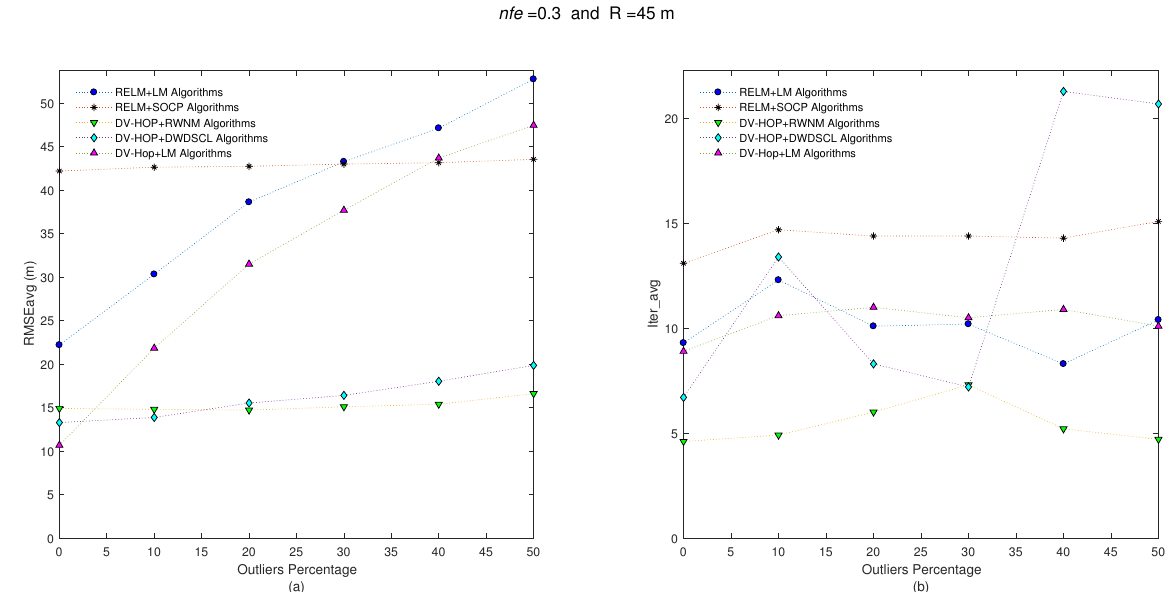
Figure 6. ( a ) RMSEavg and ( b ) Iter _ avg after running five iterative algorithms over 10 multi-hop isotropic networks with R = 45 m and nfe = 0.3. Outliers levels are increased by steps of 10% from 0% to 50%.